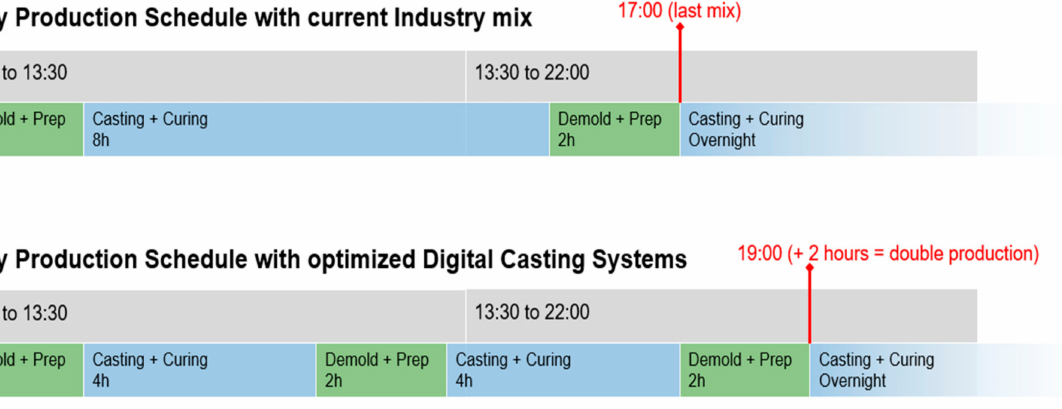
Figure 15. Comparison between the typical production and a production adopting